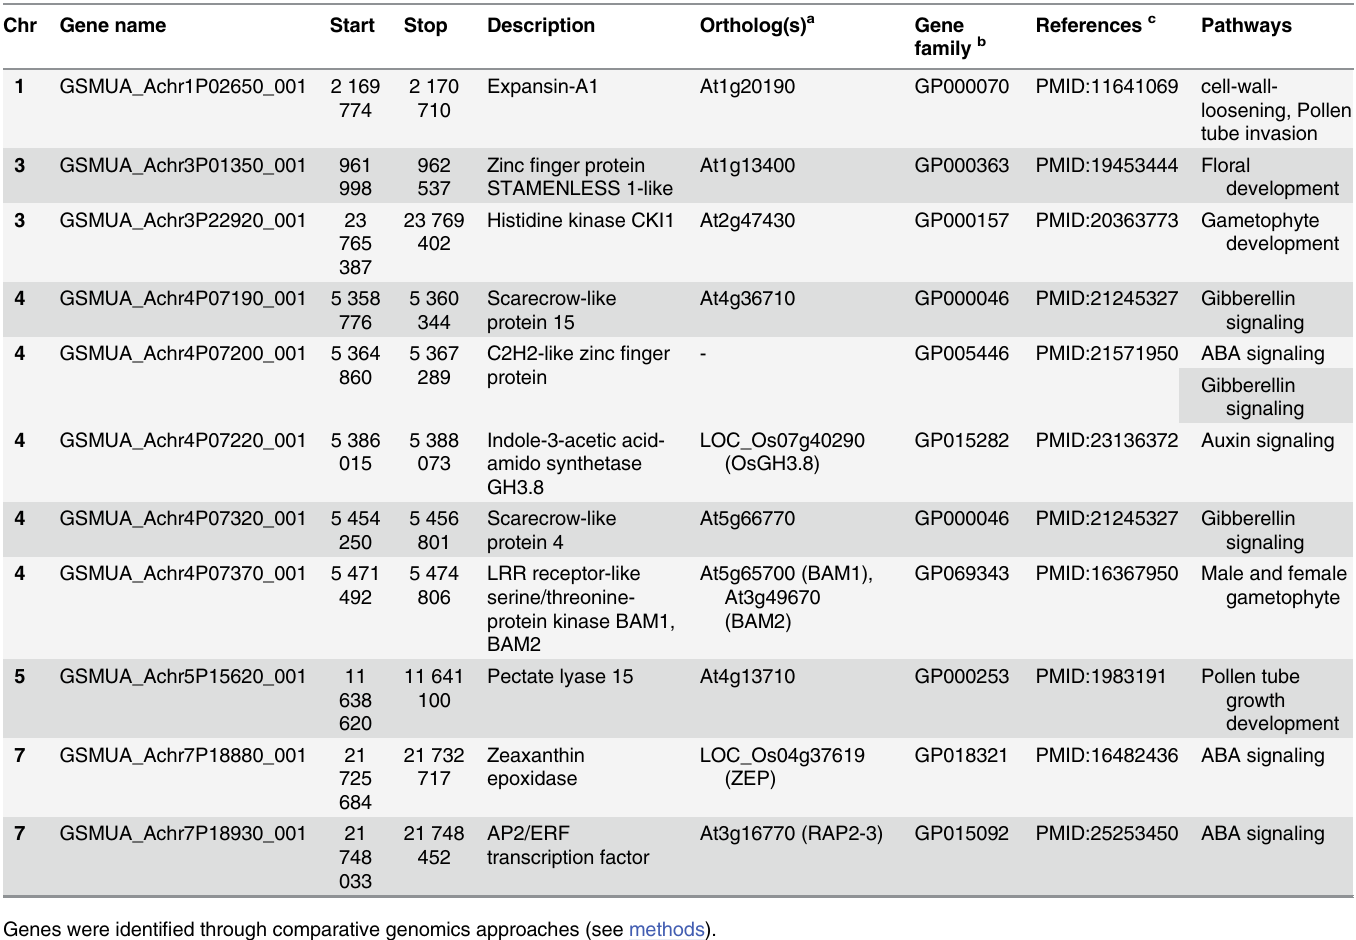
Table 5. List of candidate genes functionally